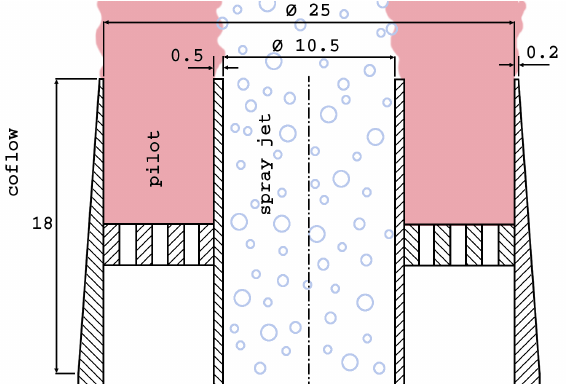
Figure 1. Schematics of the Sydney Spray Burner exit, dimensions in mm. The red colored area sketches the hot pilot consisting of burnt products.